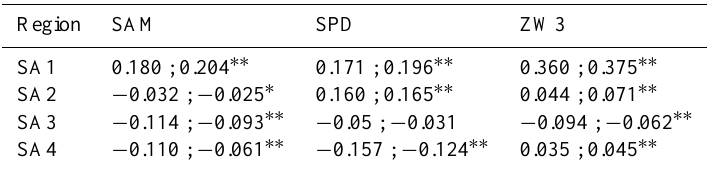
Table 2. Regional surface temperatures in the transient simulations for South America (SA1 to SA4) correlated with the Southern Annular Mode index (SAM), South Pacific Dipole index (SPD) and Zonal Wave 3 index (ZW3). For each variable and region, respectively, the highest and lowest correlation coefficients of the four ensemble members are shown. Region SAM SPD ZW3 SA1 0.180 ; 0.204 ∗∗ 0.171 ; 0.196